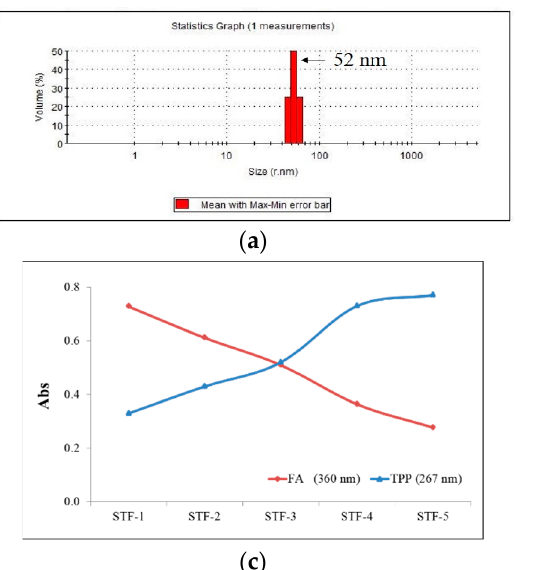
Figure 2. Scanning electron microscope (SEM) images of ( a ) SNPs, ( b ) STF-1, ( c ) STF-2, ( d ) STF-3, ( e ) STF-4, and ( f ) STF-5.